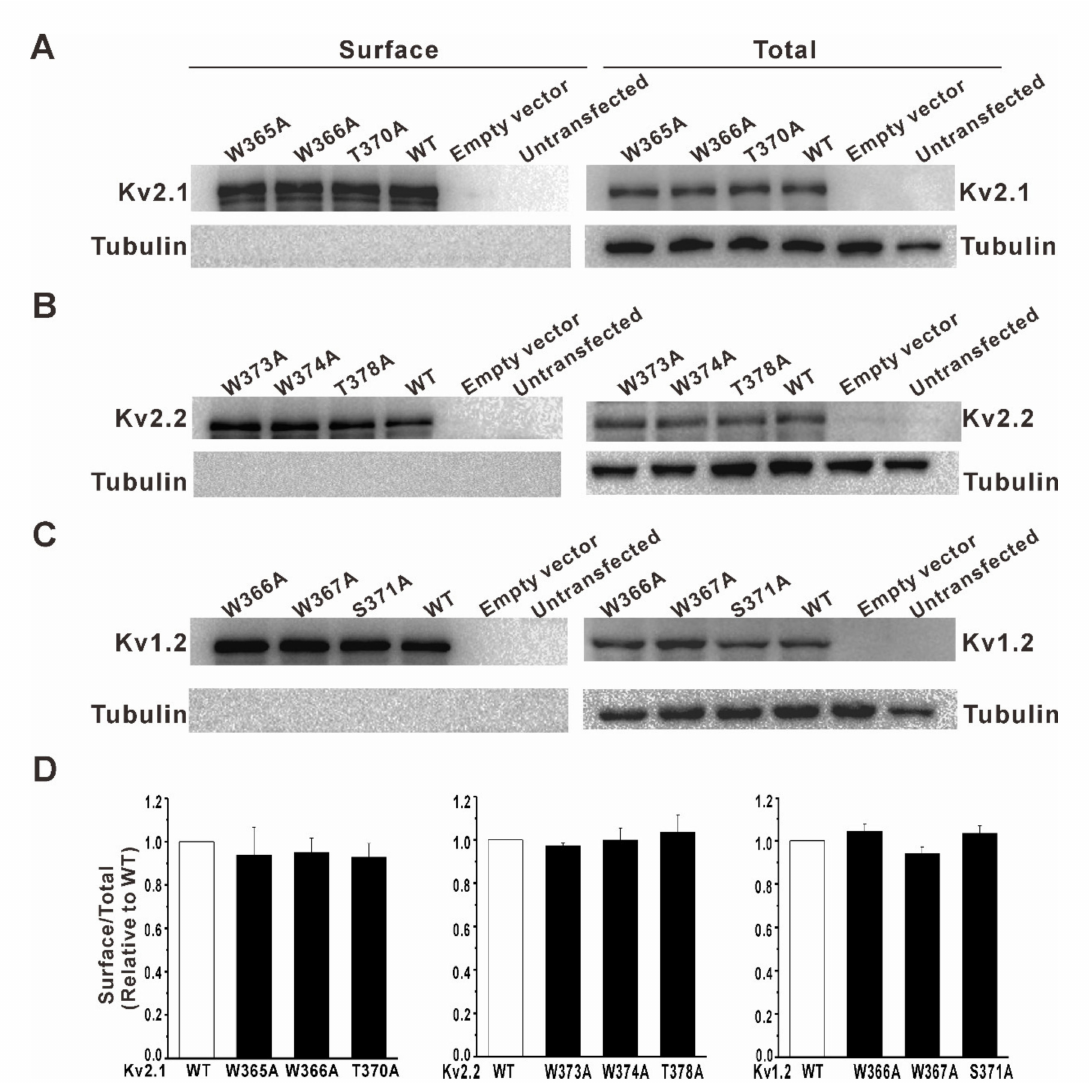
Figure 5. Cell surface expression of the various Kv channels in HEK293 cells. The Kv channel surface expression was detected using the cell surface biotinylation of HEK293 cells transfected with the wild-type/mutant Kv channels. The left panels were the biotinylated membrane protein samples, and the right panels were total protein samples. ( A ) Sample images showing endogenous or transfected wild-type/mutant Kv2.1 channel expression. ( B ) Sample images showing endogenous or transfected wild-type/mutant Kv2.2 channel expression. ( C ) Sample images showing endogenous or transfected wild-type/mutant Kv1.2 channel expression. The signals of the intracellular protein beta-tubulin were detected only in the total protein samples (right panels) and not in the biotinylated surface protein samples (left panels). Endogenous cell surface protein expression of the Kv2.1, Kv2.2, and Kv1.2 channels was undetectable. ( D ) The mutations did not alter the cell surface expression of the Kv channels in HEK293 cells ( n = 3, p > 0.05, WT versus